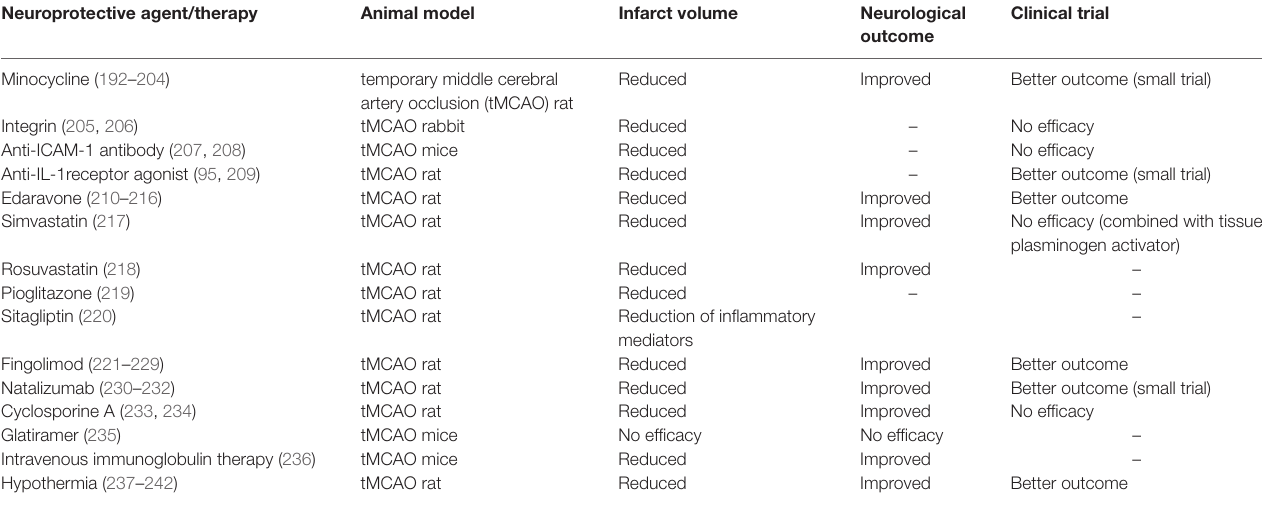
TAbLe 1 | Neuroprotective agents and therapies for ischemia-induced inflammation and reperfusion injury in experimental stroke models and clinical